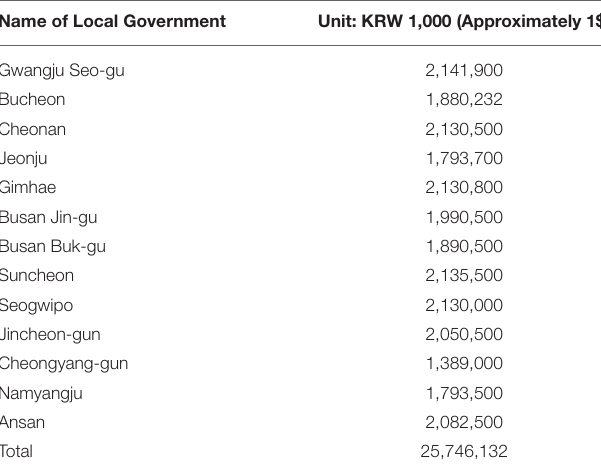
TABLE 2 | Budget status by region for the pilot program for integrated care for the elderly in the local community. Name of Local Government